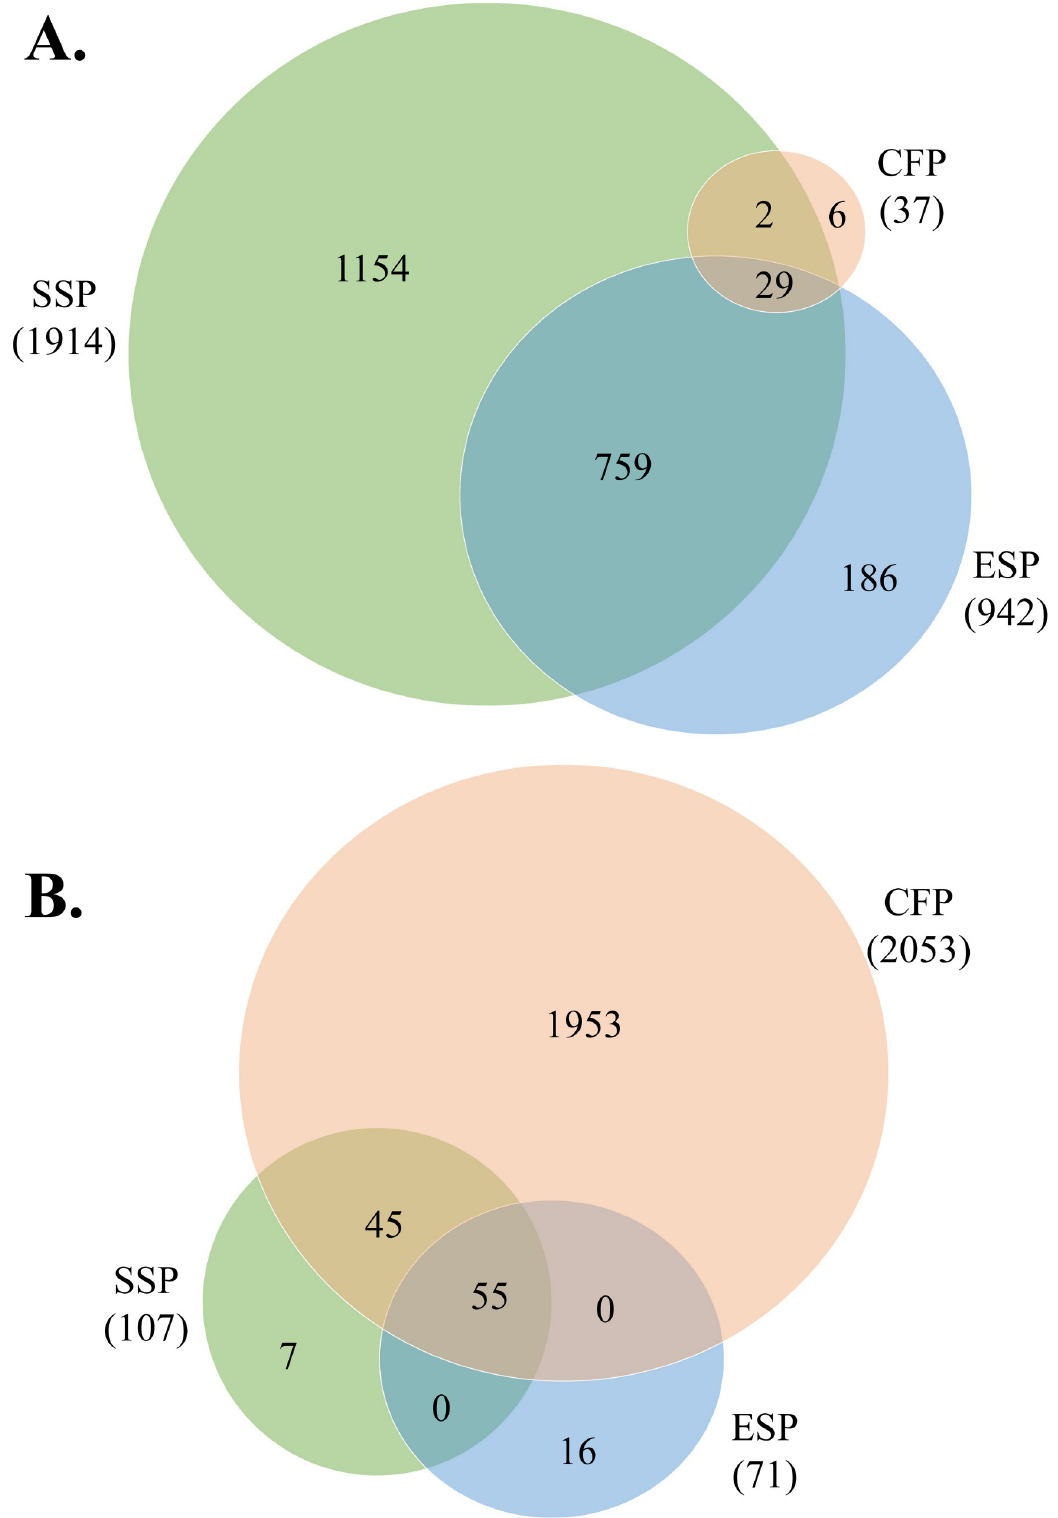
Fig 1. Venn diagrams representing the number of proteins found in each sample type, soluble somatic proteins (SSP), excretory/secretory proteins (ESP), cyst fluid proteins (CFP). The overlap region between the circles shows proteins present